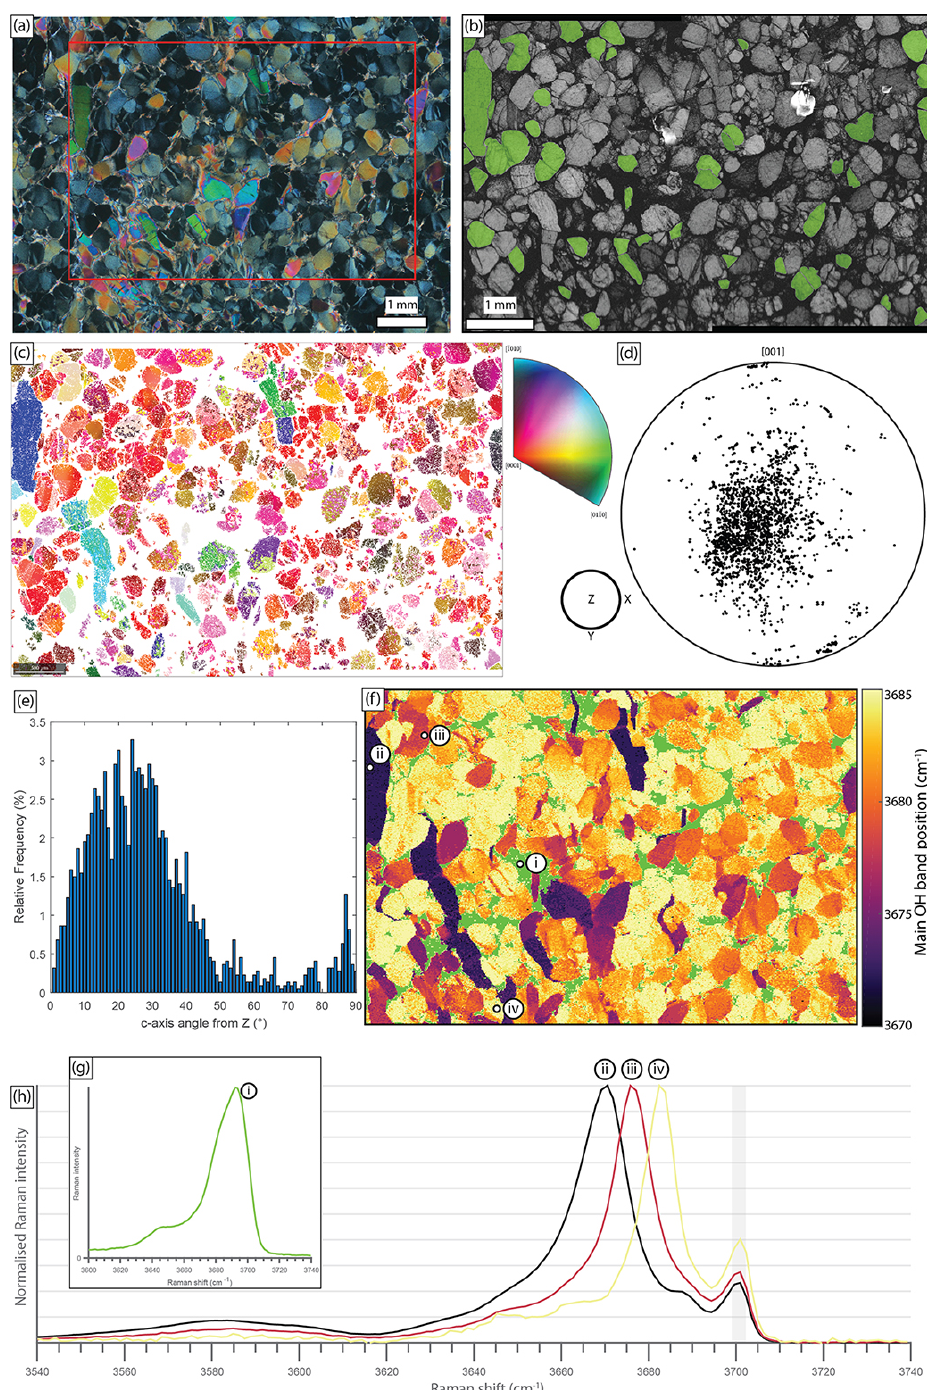
Figure 3. EBSD and Raman map 1 on thin section MF01 ⊥ . (a) Cross-polarised light photomicrograph with mapped area in the red box. (b) Image quality band contrast map from EBSD analysis. (c) Inverse pole figure (IPFZ) map from EBSD analysis coloured with the inverse pole figure scheme shown on the right. (d) Pole figure (lower-hemisphere equal area, one point per grain) of [001] orientations ( c -axis). (e) Histogram of the relative frequency of the c -axis angle from z for each grain. (f) Raman-based map displaying the position of the main OH-stretching band of lizardite. Green areas represent chrysotile-dominated matrix. (g) Representative spectrum of the chrysotile matrix (corresponding to point i in panel f ). (h) Select spectra from the Raman map for grains with c -axis close to the plane of section (ii), intermediate in orientation (iii), and with c -axis close to normal relative to the plane of section (iv). The light grey rectangle highlights the secondary peak at 3701cm − 1 observed in all